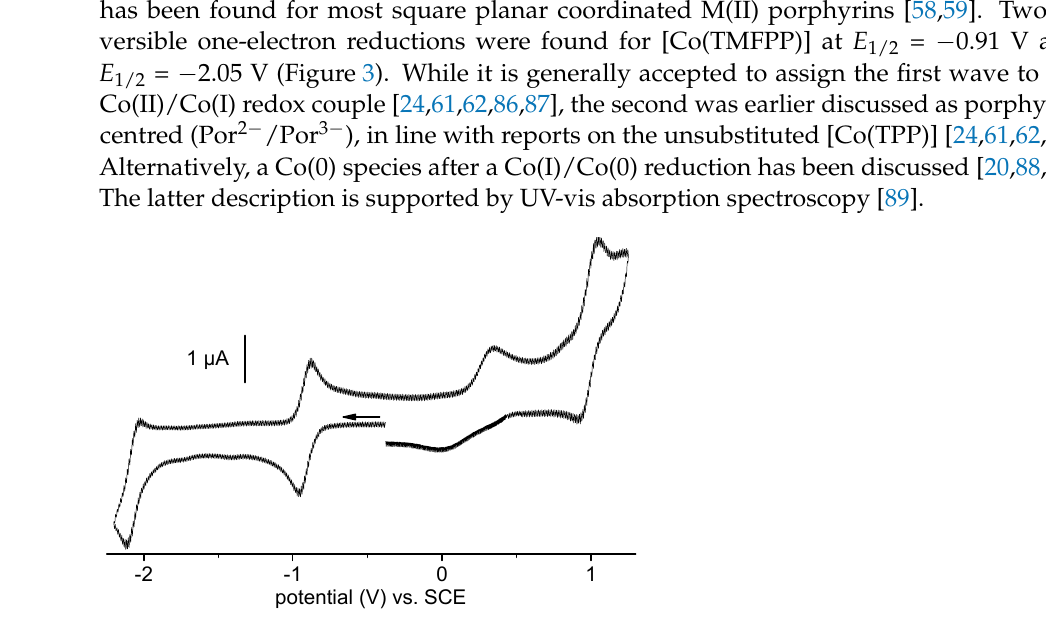
Figure 3. Cyclic voltammogram of [Co(TMFPP)] in 0.1 M n Bu 4 NBF 4 /DMF, recorded at 100 mV s − 1 .